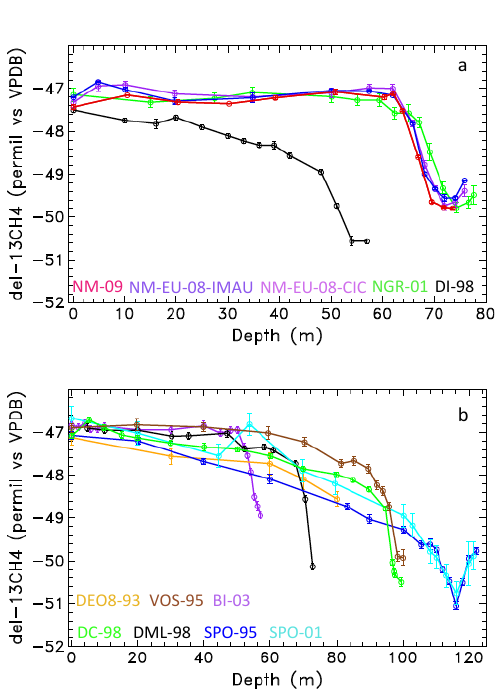
Figure 1: Vertical profiles of δ 13 C(CH 4 ) in firn air. a: The NH sites are: Devon Island (DI), North GRIP Fig. 1. Vertical profiles of δ 13 C(CH 4 ) in firn air. (a) The NH sites (NGR), NEEM 2009 (NM-­‐09), NEEM-­‐EU 2008 (NM-­‐EU-­‐08) measured by IMAU and CIC. b: The SH sites are Devon Island (DI), North GRIP (NGR), NEEM 2009 (NM- 09), NEEM-EU 2008 (NM-EU-08) measured by IMAU and CIC. (b) The SH sites are DE08-2 (DE08), Berkner Island (BI), Vostok (VOS), Dronning Maud Land (DML) and Dome Concordia (DC) (Bräunlich et al., 2001), South Pole 1995 (SPO-95) and South Pole 2001 (SPO-01) (Sowers et al., 2005). The numbers associated with the names on the legend are the dates (year) of the firn sampling for each site.